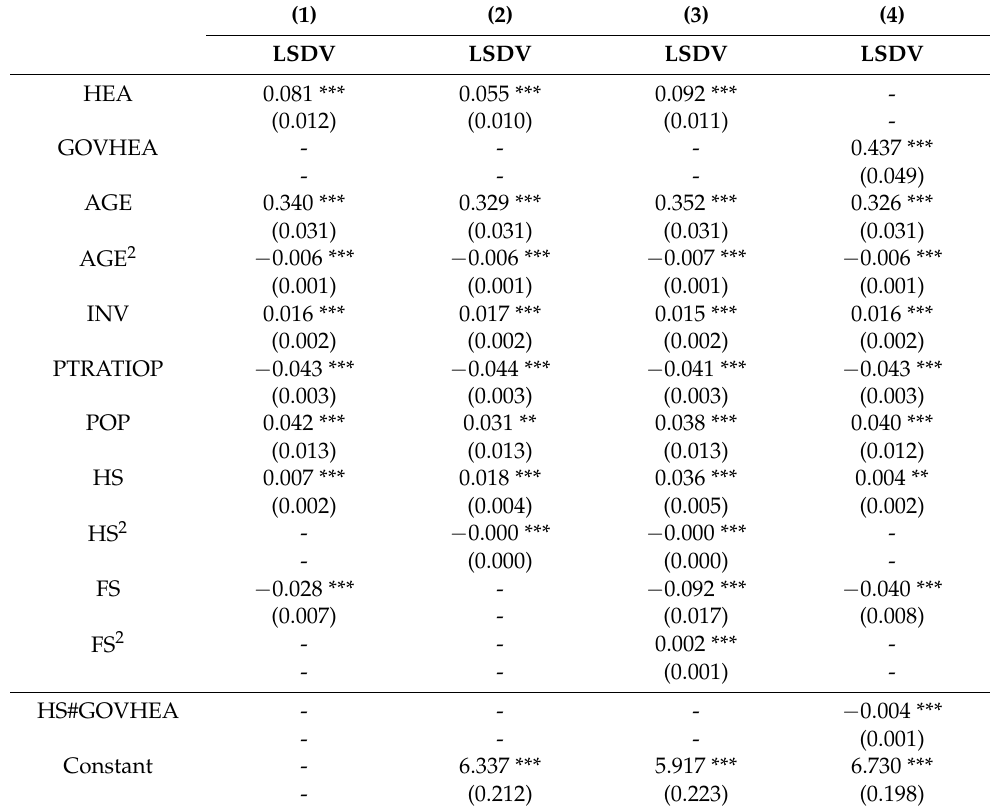
Table 7. Health investment structure, financial expenditure structure, and economic